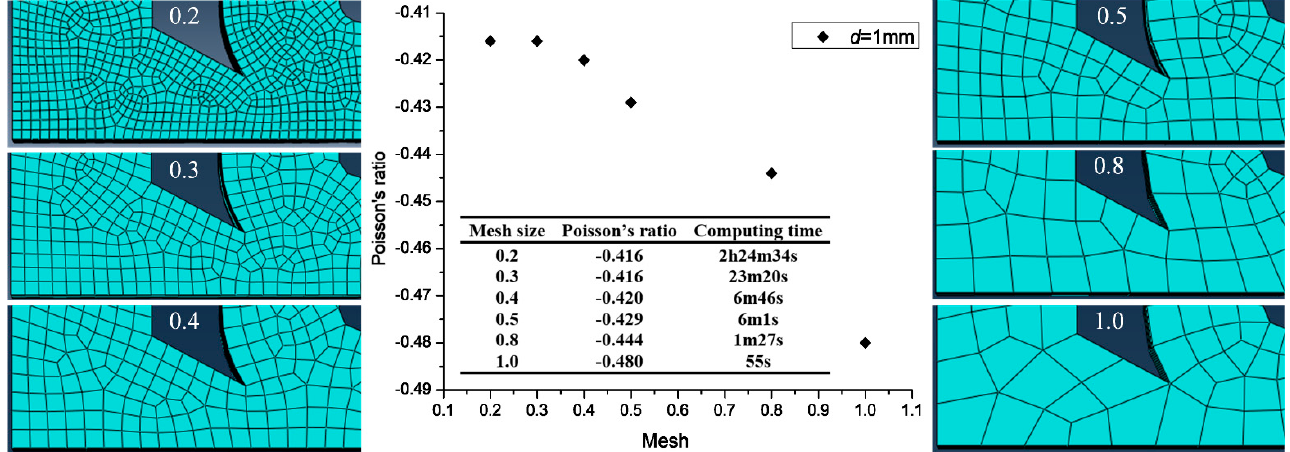
Figure 8. Relationship between the mesh size and Poisson’s ratio using the model with the hollow circle diameter d = 1 as an example.